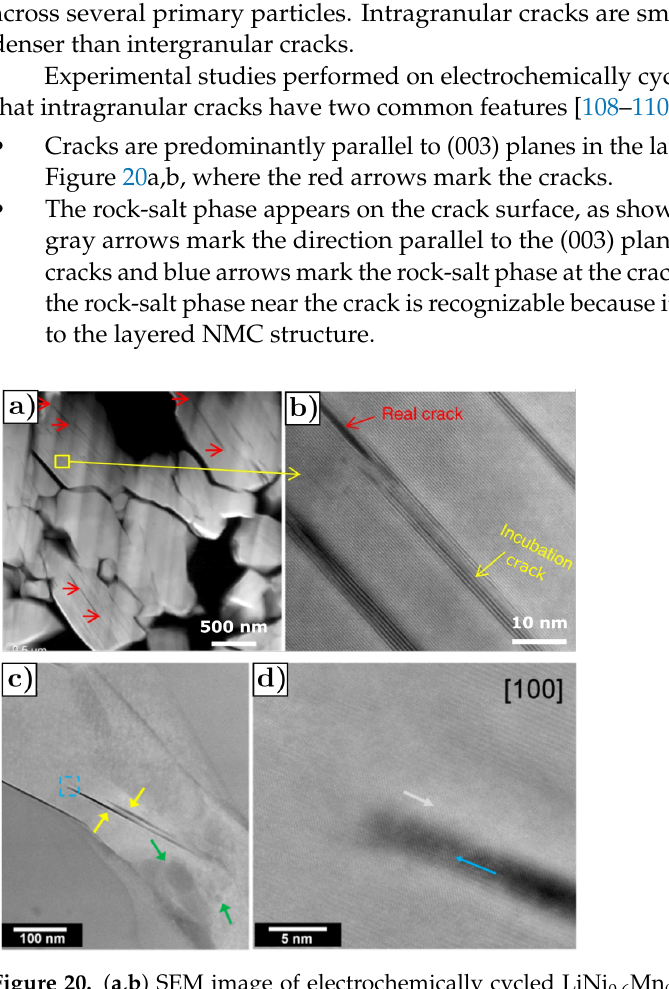
Figure 20. ( a , b ) SEM image of electrochemically cycled LiNi 0.6 Mn 0.2 Co 0.2 O 2 (NMC622) particles, showing cracks parallel to the (003) planes. Cracks are marked with red arrows. Reprinted with permission of [109] ©2018 Springer Nature. ( c ) Intragranular cracks in Li 1+x (Ni 0.85 Co 0.1 Mn 0.05 ) 1–x O 2 (NCM851005) after 200 cycles, with ( d ) High-resolution image of the marked area in ( c ) showing the rock-salt phase along the crack surface. The direction parallel to (003) planes, cracks and the rock-salt phase are marked with grey, yellow and blue arrows, respectively. Reprinted with permission from American Chemical Society by [110], Copyright